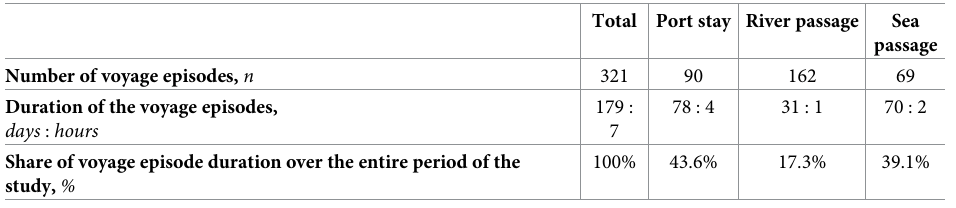
Table 1. Overview of the distribution of the three voyage episodes during all 22